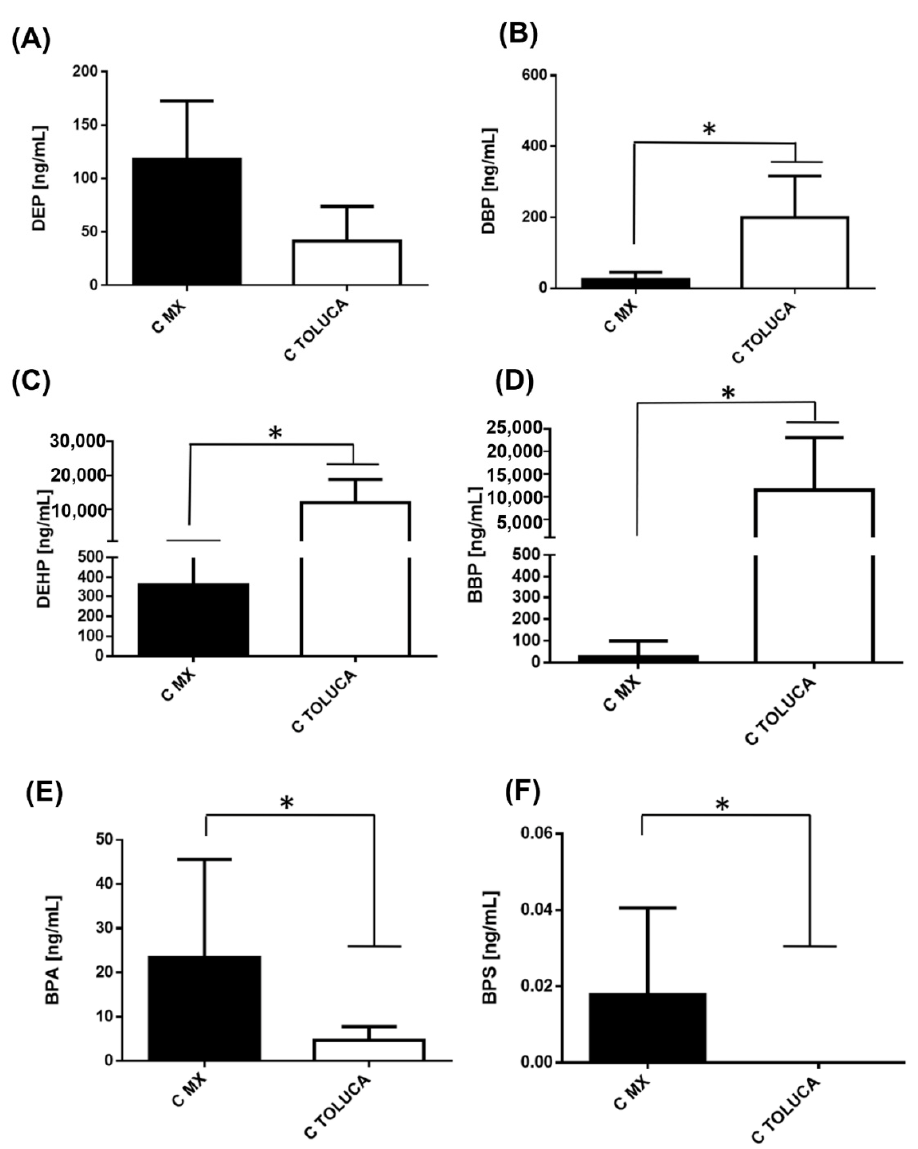
Figure 1. Levels of phthalates and bisphenols in women without BC Serum concentration levels of phthalates ( A ) DEP, ( B ) DBP, ( C ) DEHP, ( D ) BBP, ( E ) BPA, ( F ) BPS were measured in women ( C ) from Mexico City (black bar) and Toluca City (white bar). Bars represent the mean ± S.D. * p < 0.05 was considered statistically significant.